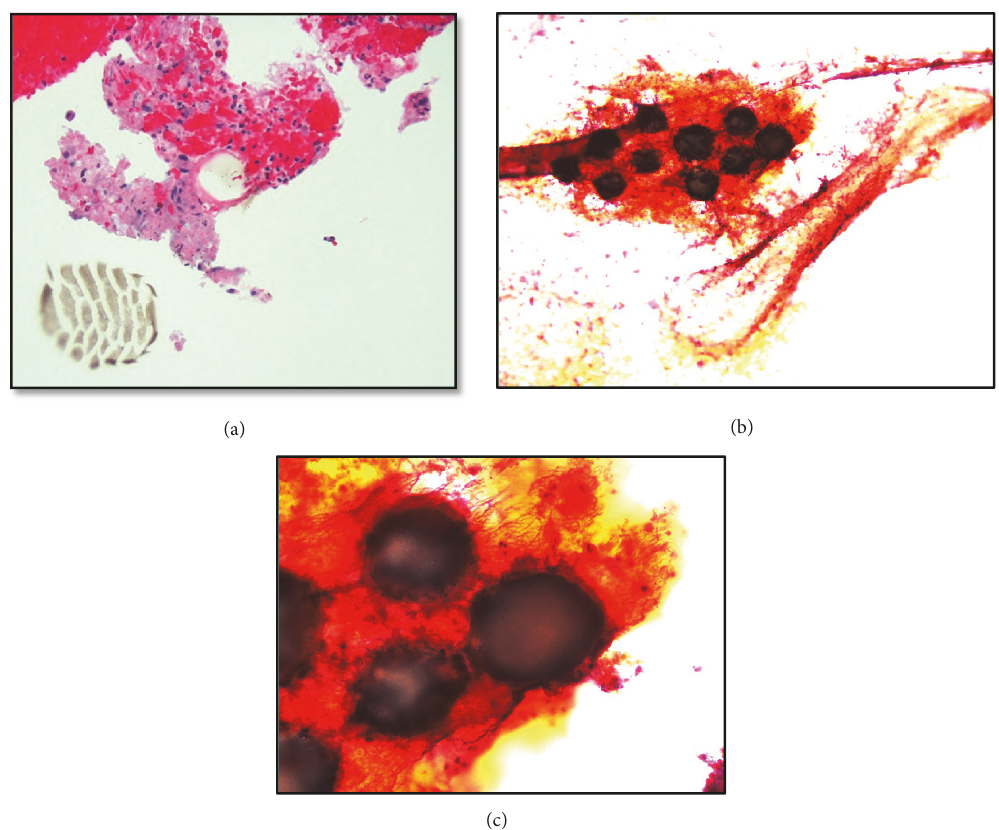
Figure 2: (a) Rectal FNA biopsy (H&E, 20X) with strips of benign colonic mucosa and the presence of giant cells, reactive macrophages, acute inflammatory cells, mucin, and foreign material. (b) Dark blue/purple dextranomer microspheres and hyaluronic acid (10X). (c) Dark blue/purple dextranomer microspheres and hyaluronic acid